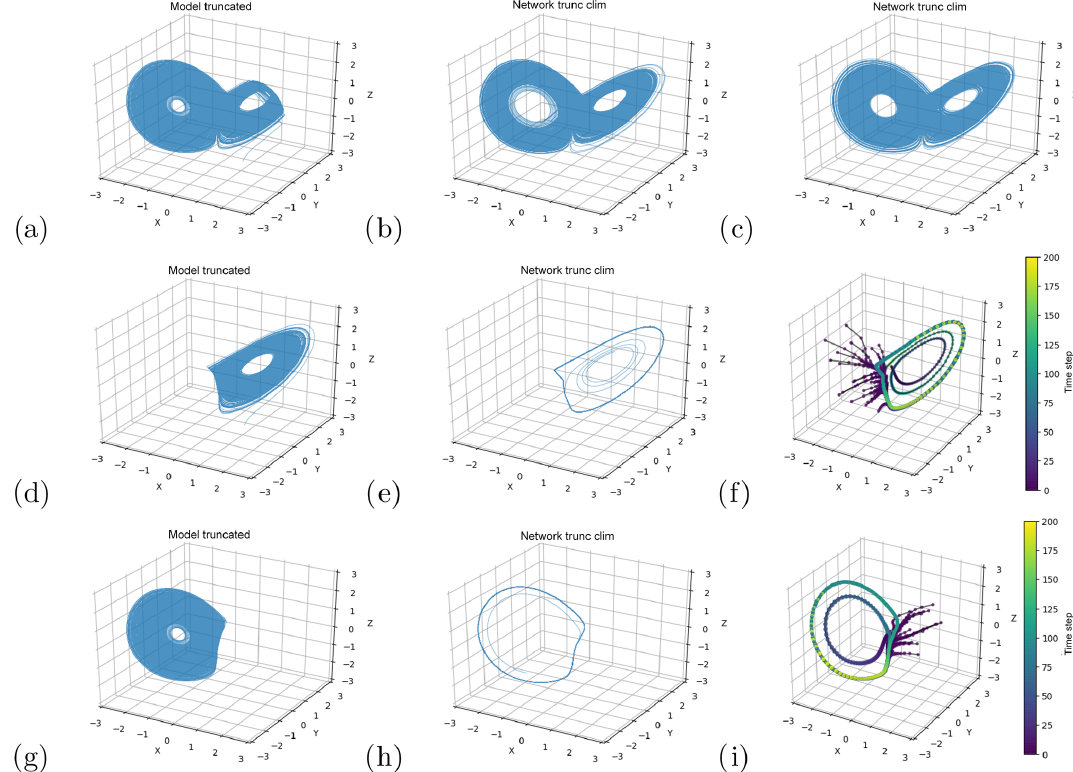
Figure 5. Reconstruction of the Lorenz63 system with neural networks trained on truncated data. (a, d, g) Truncated sets of Lorenz63 training data. Reconstructed attractors with networks trained on (a) and selected using the density-full (b) and density-selection (c) approaches. (e, h) Reconstructed attractors trained on (d) and (g) respectively, selected based on having no repeated points. (f, i) trajectories initialized with random points from the region of the attractor that was left out in the training data in (d) and (g) , respectively. The points in (f) and (i) indicate single forecast